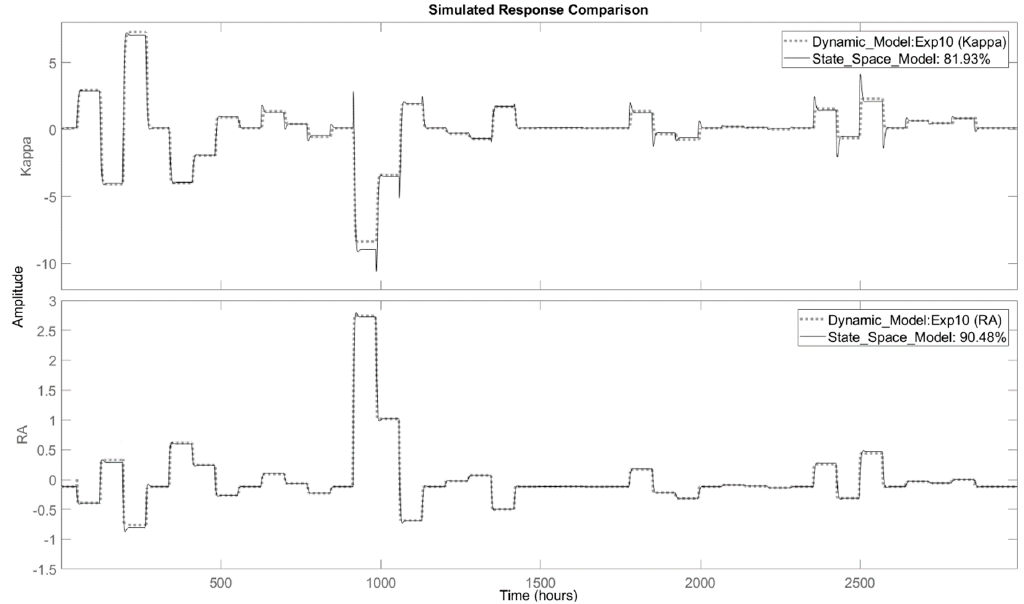
Figure 8. Comparison of the second order state-space model response against the dynamic model.